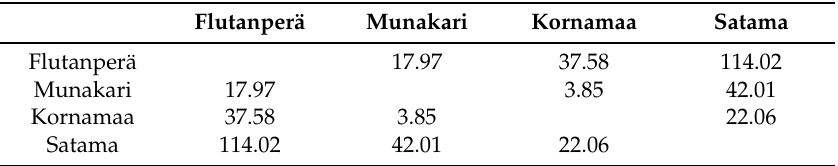
Table 11. The calculated between-class variability between reed sites. Table 12. The calculated JM-distances between reed